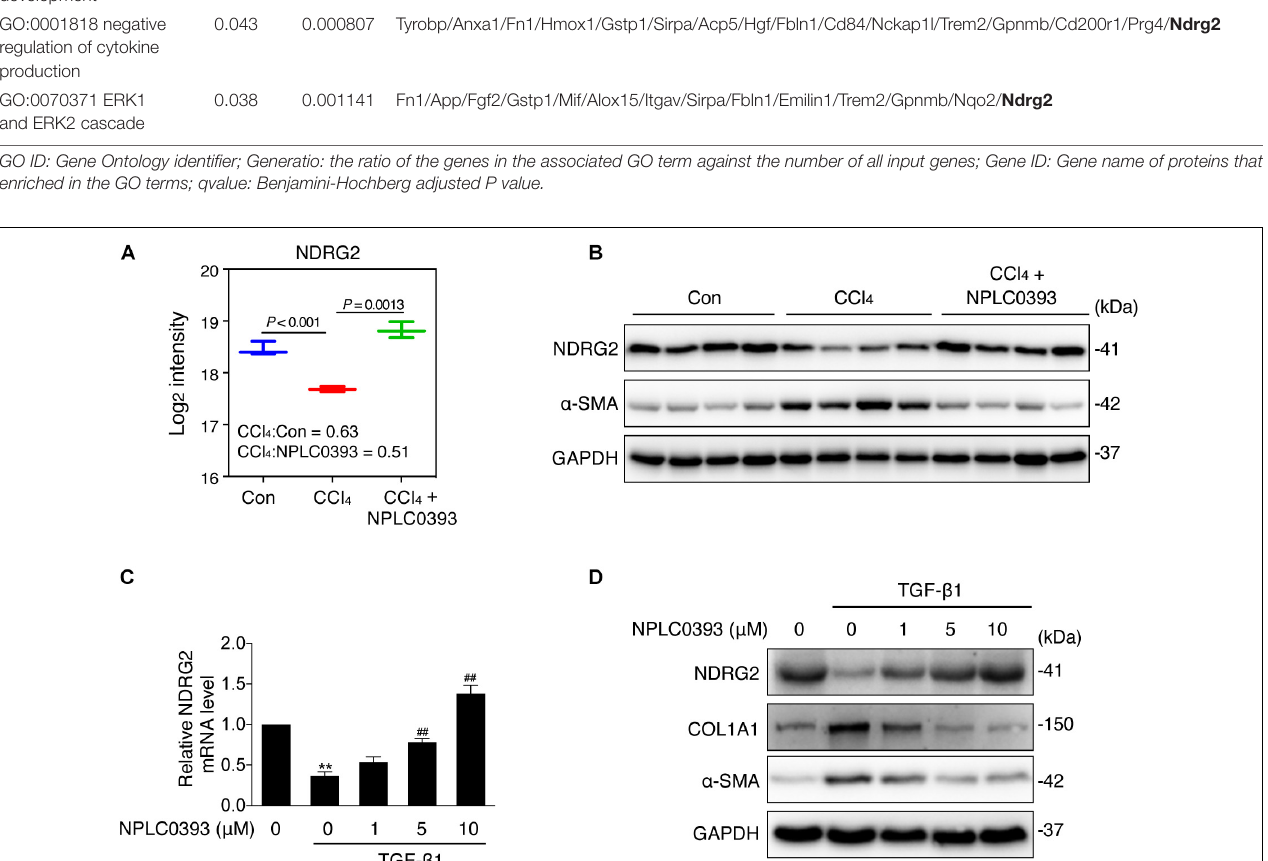
Frontiers in Genetics |